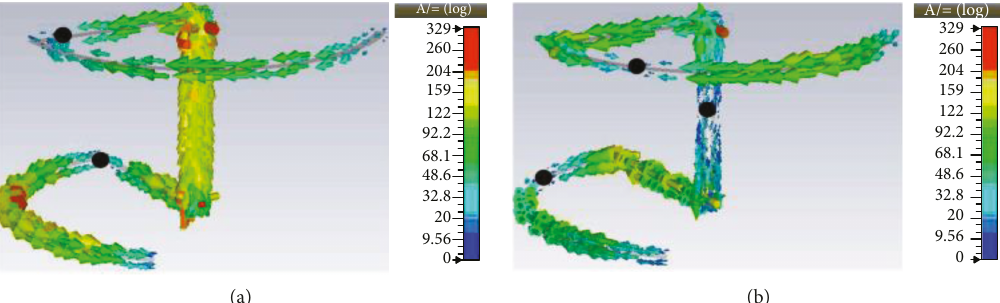
Figure 6: Current distributions of two modes: (a) mode 2 resonance at 12.2GHz under LHCP with two nulls and (b) mode 3 resonance at 15.4GHz under RHCP with three nulls.